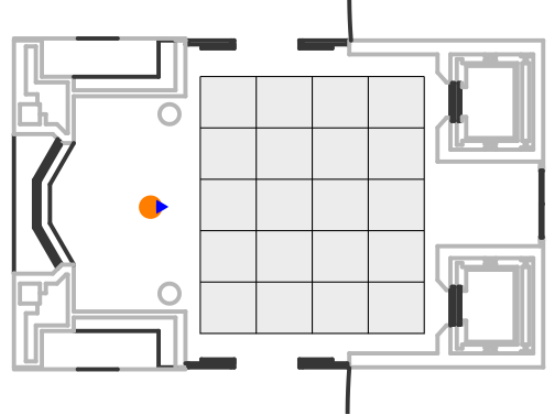
Figure 9. Ground Truth: Indoor